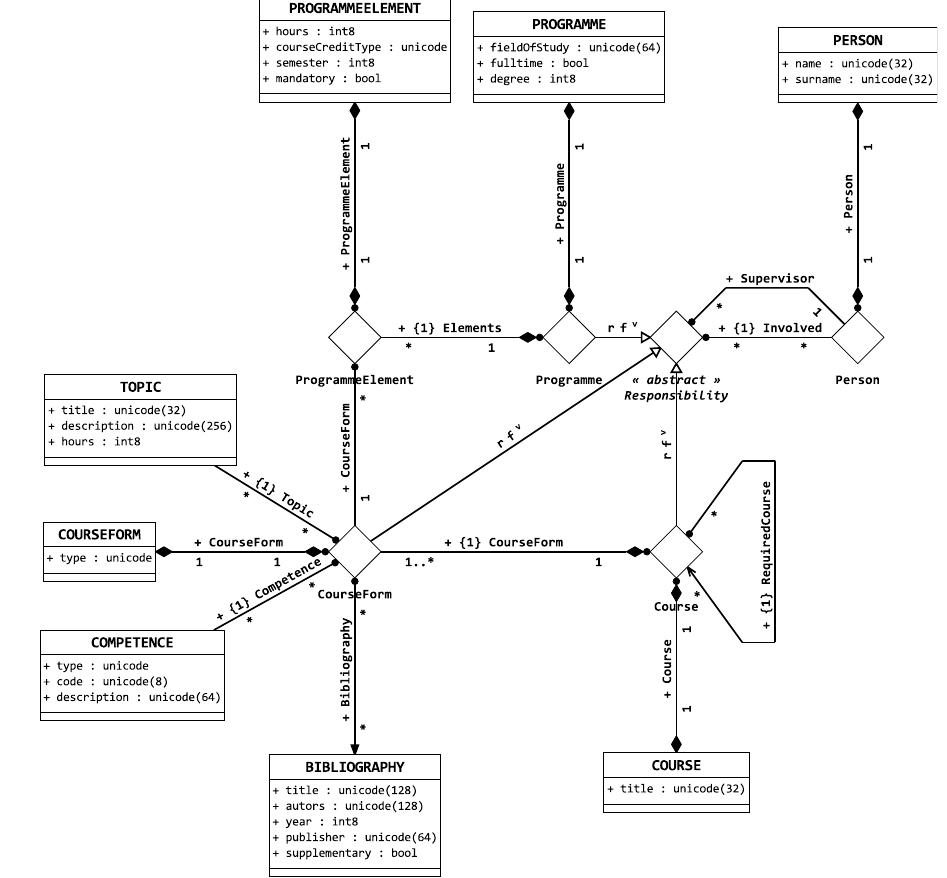
Fig. 18. The AML AO model of simpli¯ed studies de¯nition DB